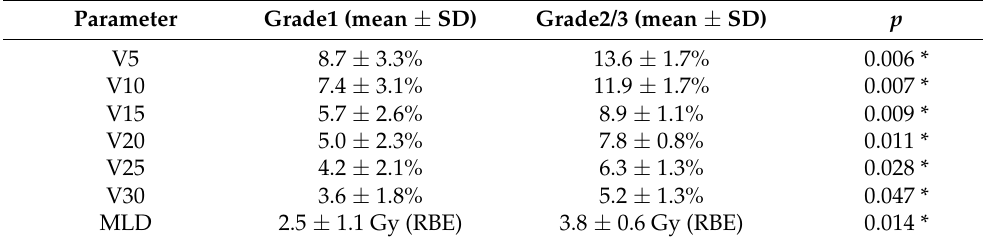
Table 2. The correlation between dose–volume parameters of all lung and radiation